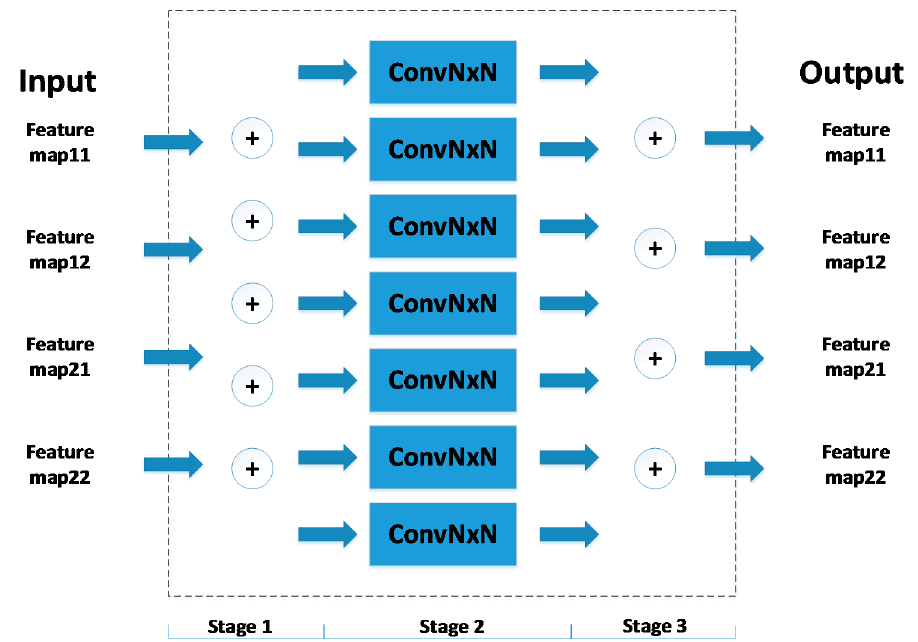
Figure 6. Architecture of the matrix convolution based on the Strassen algorithm.